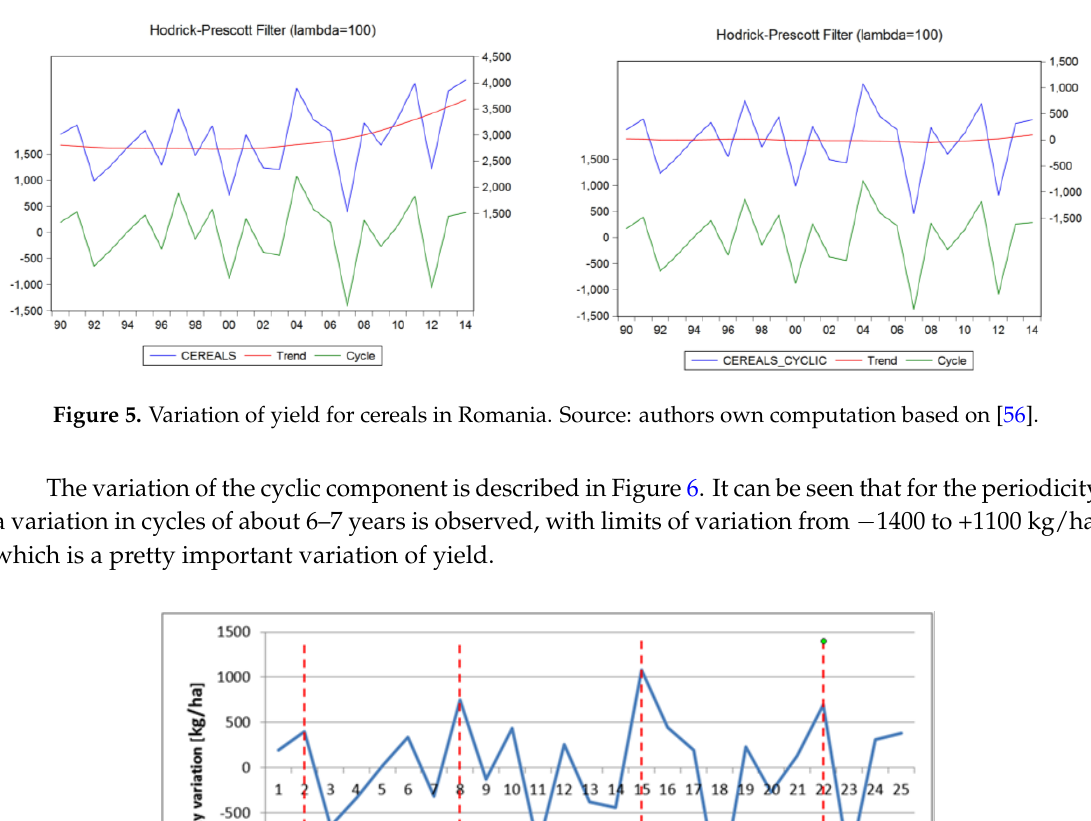
Figure 5. Variation of yield for cereals in Romania. Source: authors own computation based on [56].